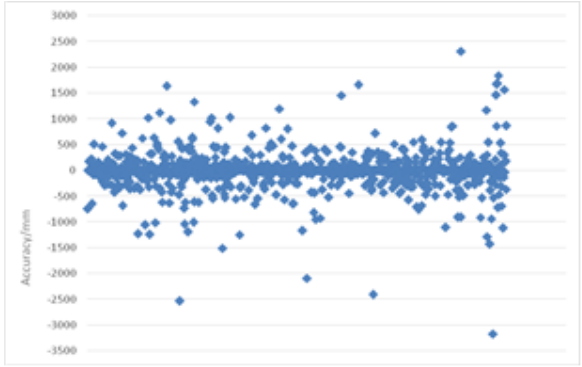
Figure 4. Accuracy (map distance) in North-South direction The statistical graph shows that the N accuracy on most points is about 5 meters (in Figure 4). And the E accuracy is about 5 meters on all most of points (in Figure 5).